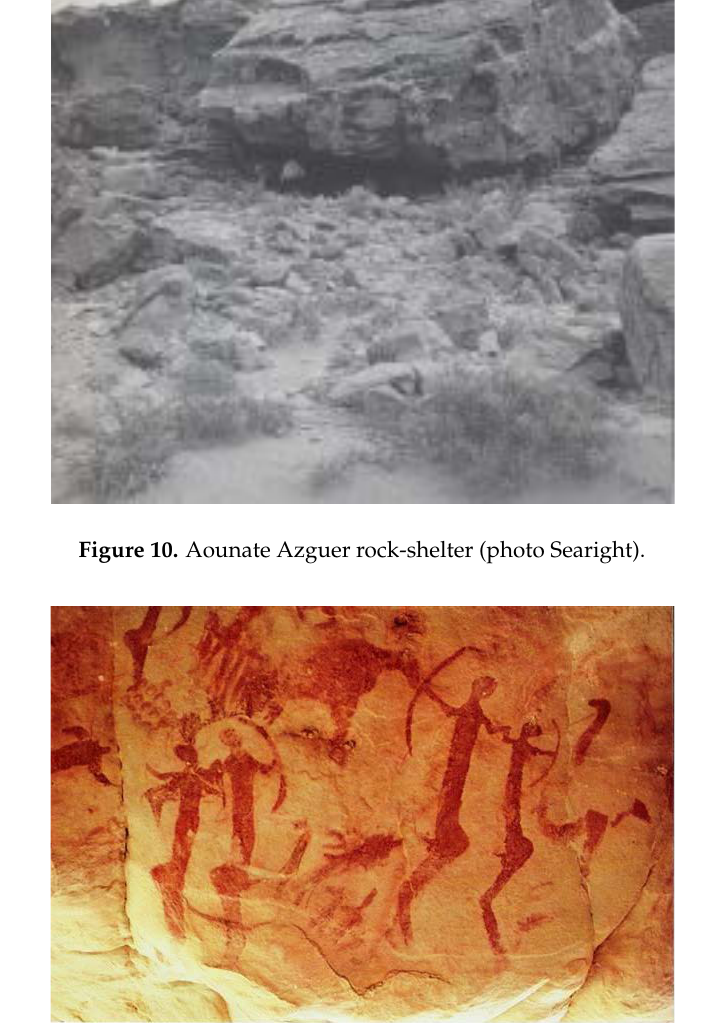
Figure 11. Aounate Azguer painted panel (photo Searight).